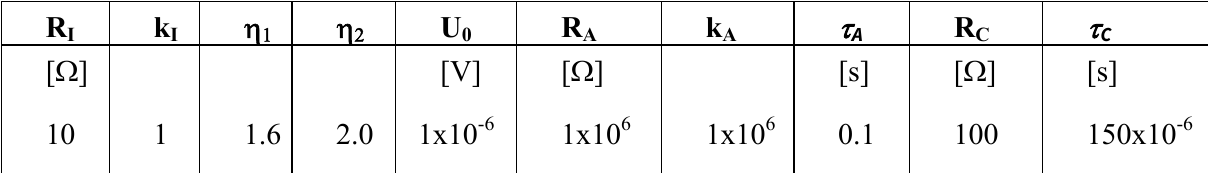
Table 2. Parameters of the simulated measuring